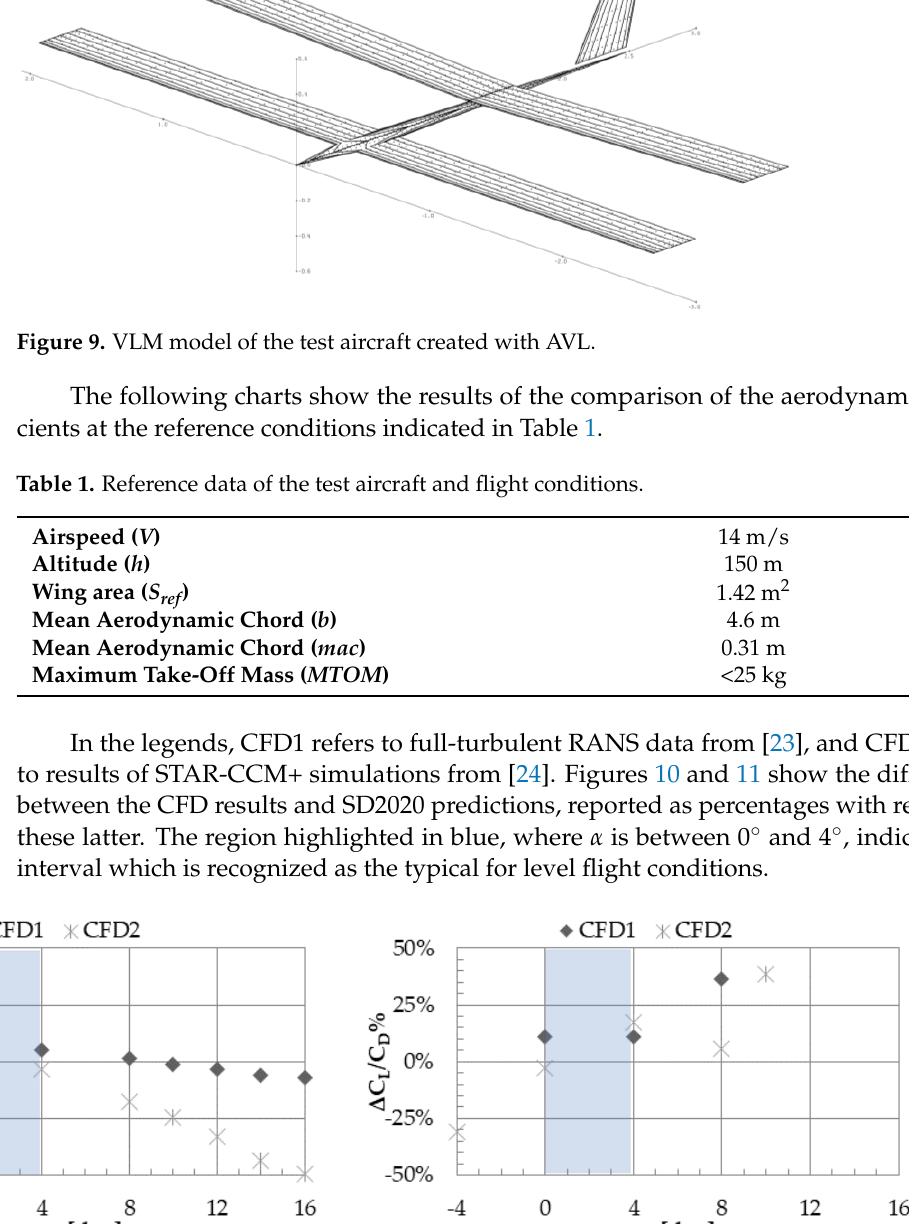
Figure 10. Percentage differences on lift coefficient ( 𝐶 𝐿 , left ) and lift-to-drag ratio ( 𝐶 𝐿 𝐶 𝐷 ⁄ , right ) predictions (SD2020 underestimates when values are positive).